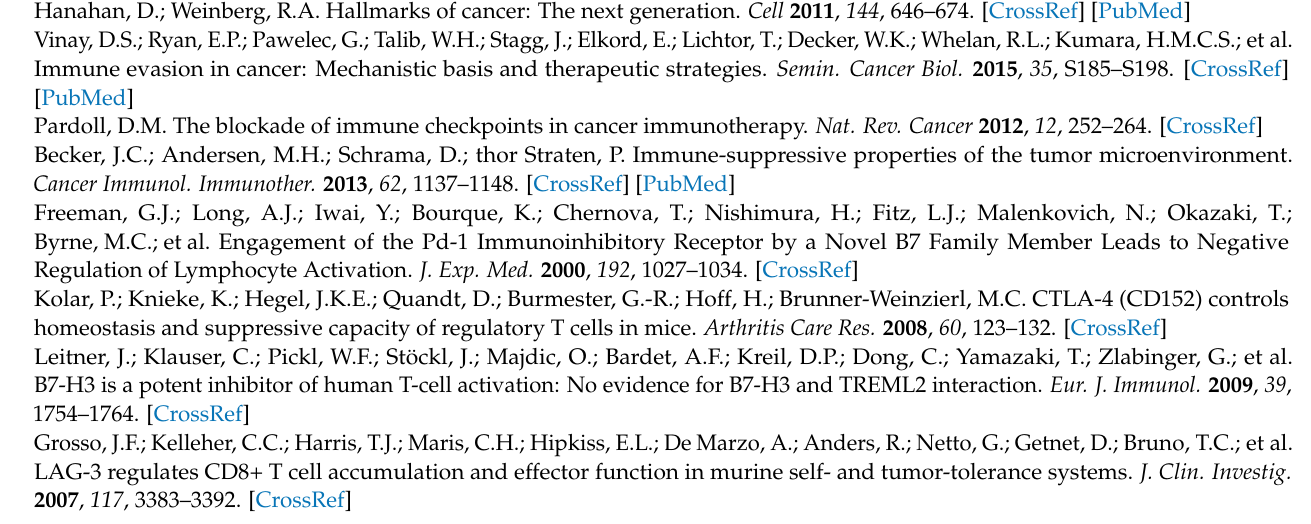
Figure S3: Association of immune checkpoint markers with hallmark pathways in TCGA datasets, Figure S4: Association between EMT and metabolic axes with CD274 gene expression in single-cell RNA sequencing data (GSE147405), Figure S5: Survival analysis for PD-L1 and glycolysis gene signatures in several TCGA patient cohorts across cancer types, Figure S6: Cox proportional hazard ratios for immune checkpoint markers in different TCGA datasets, Table S1A: Description of the 184 bulk transcriptomic datasets used in this study, Table S1B: Gene sets used for scoring EMT, metabolic and PD-L1 gene signatures, Table S1C: Spearman’s Correlation coefficient ‘R’ and corresponding p -values for correlation of PD-L1 gene signature and immune checkpoint markers with KS, 76GS, Epi, Mes and pEMT scores, Table S2: Spearman’s Correlation coefficient ‘R’ and corresponding p -values for correlation of PD-L1 gene signature and immune checkpoint markers with glycolysis, HIF-1 α , and OXPHOS scores, Table S3: Spearman’s Correlation coefficient ‘R’ and corresponding p-values for correlation of immune checkpoint markers with different hallmark pathways in TCGA cohorts, Table S4A: Spearman’s Correlation coefficient ‘R’ and corresponding p -values for correlation between CD274 gene expression, E/M scores, and scores for metabolism in cell line samples of GSE147405, Table S4B: Spearman’s Correlation coefficient ‘R’ and corresponding p -values for correlation between KS vs. Mes, Epi vs. Mes, and Ks vs. Epi for cell line samples in GSE147405, Table S5: Log2 hazard ratios, mean ± 95% confidence intervals and corresponding p -values for overall survival associated with CD274 gene expression across several TCGA cancer